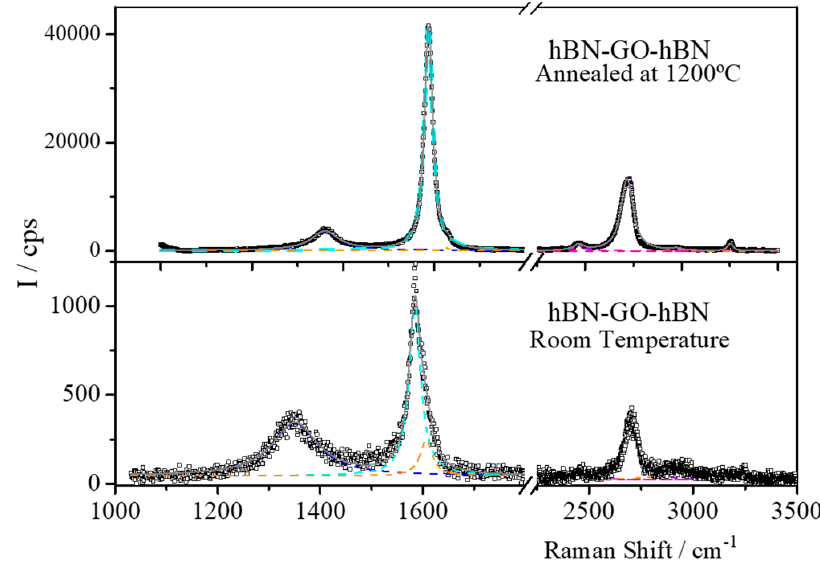
Figure 3. Raman spectra of the h -BN-GO- h -BN heterostructure (room temperature) and annealed at 1200 °C. Symbols represent experimental spectra; dashed lines represent the functions into which we split the spectrum and solid lines are fits to the data.